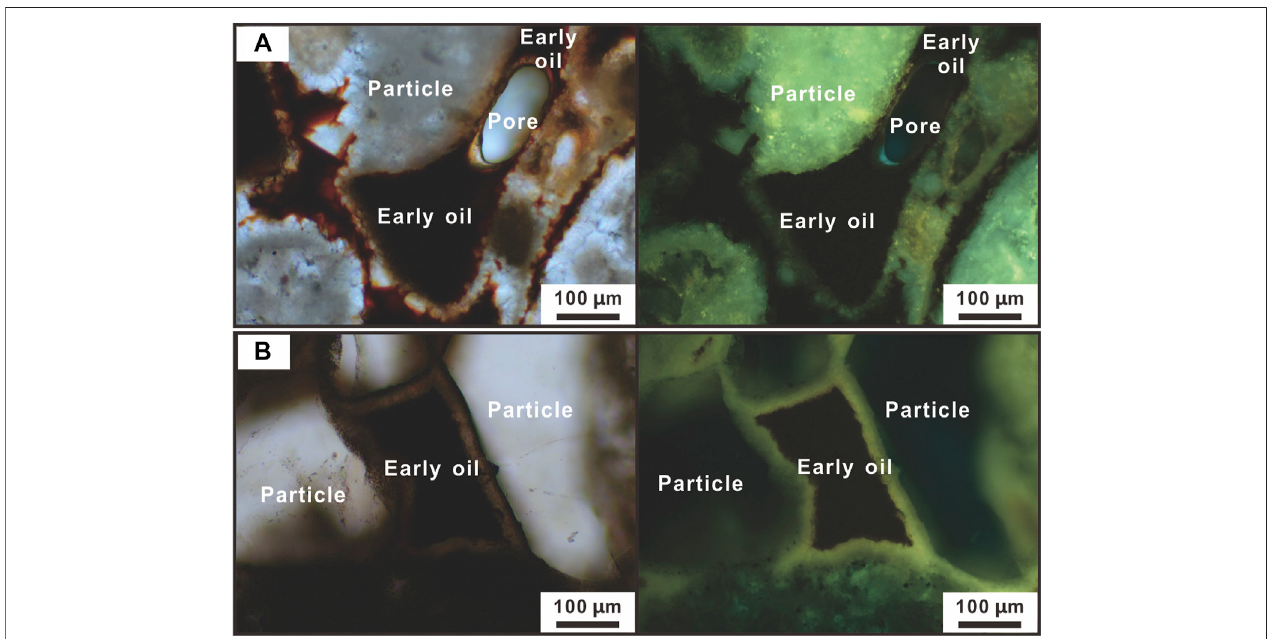
FIGURE 9 | (A – B) Emplacement of the early hydrocarbon (bitumen) in the sandstone in the Dongying Depression.